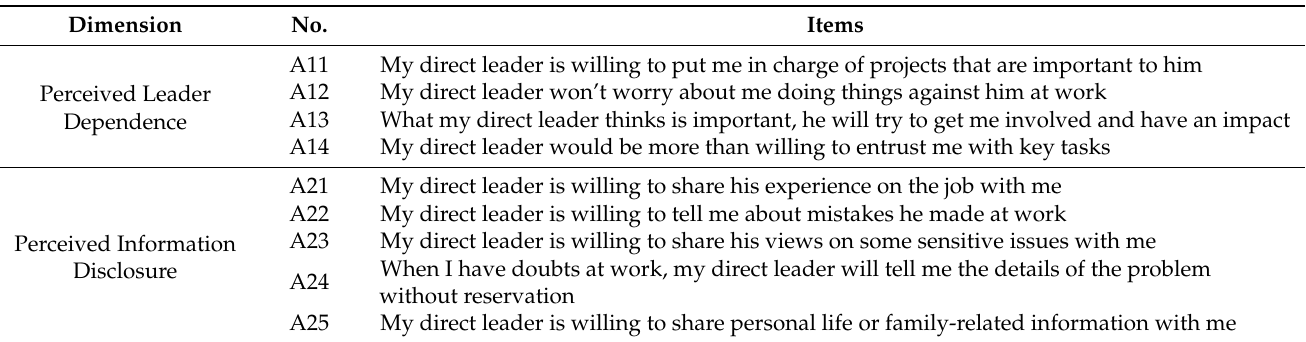
Table 1. Perceived Leader Trust Measurement Items.